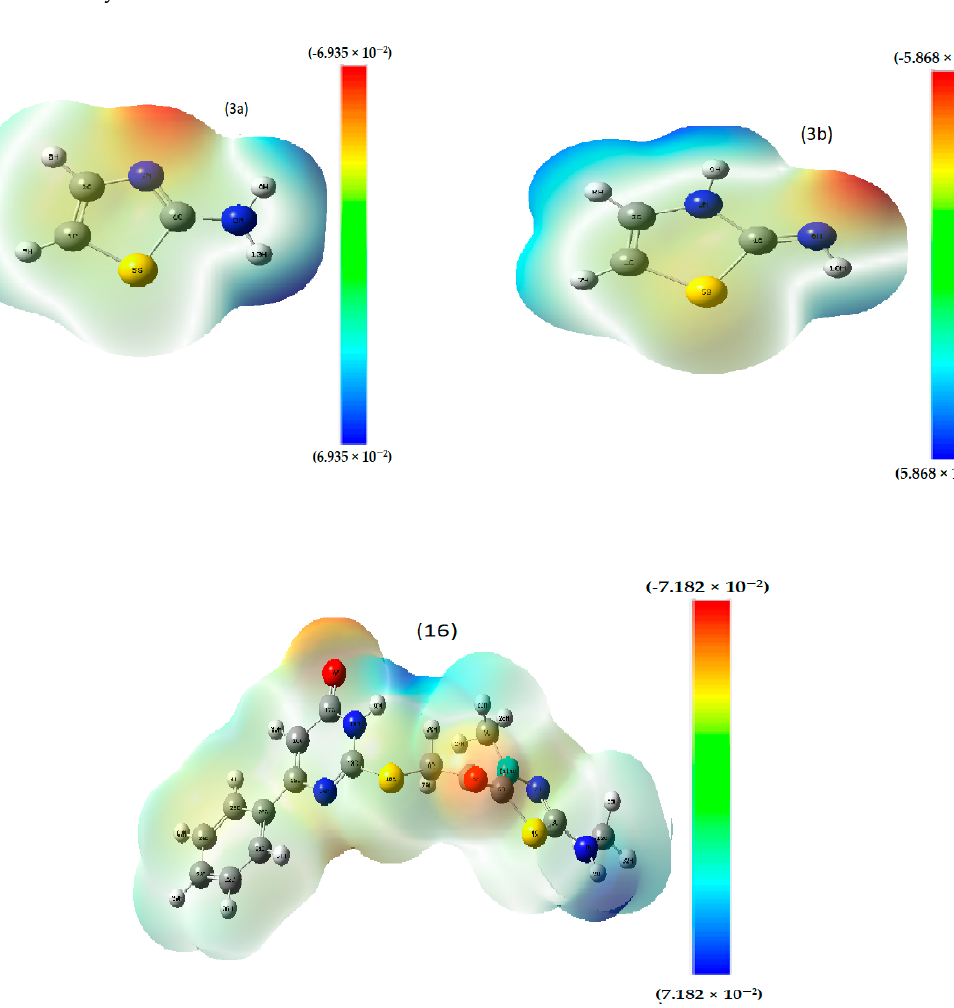
Figure 4. Electrostatic potential of selected reaction determining compounds.